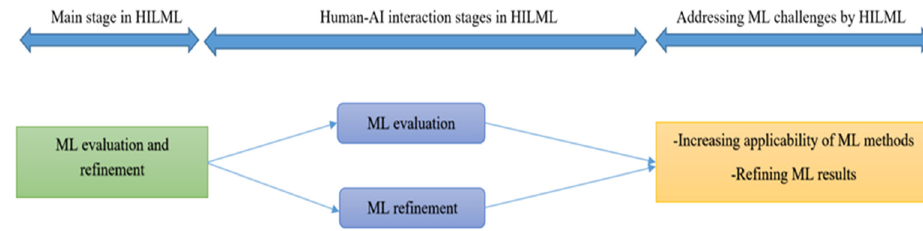
Figure 3. A framework overview of human–AI interaction in ML evaluation and refinement.